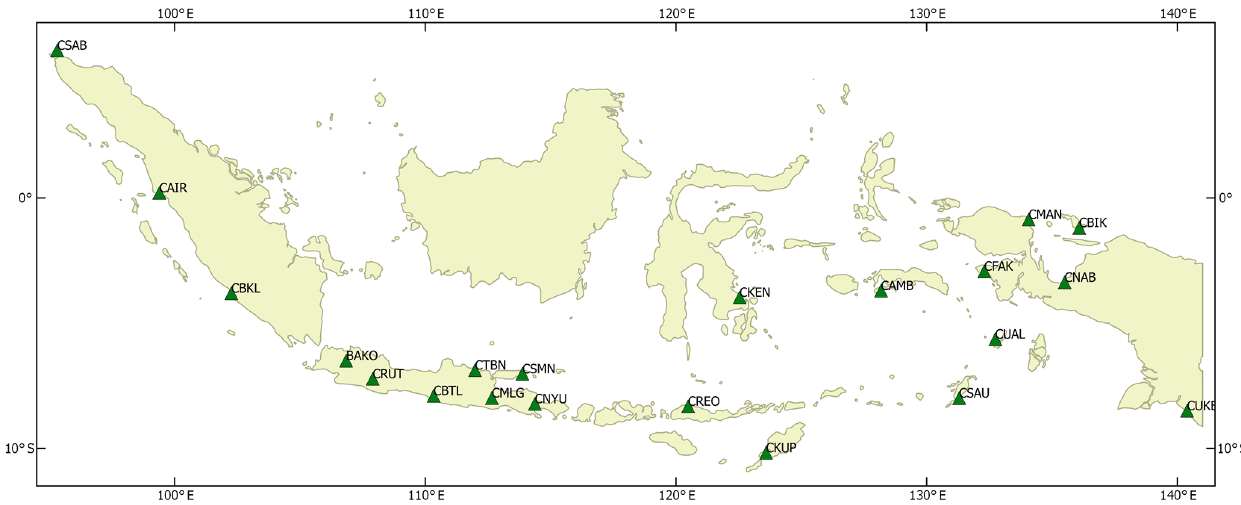
Figure 1. InaCORS stations used in the data